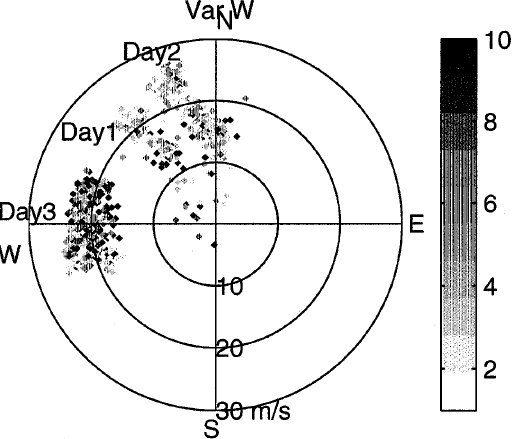
Fig. 7. Variance of vertical wind ( gray scale ) as a function of horizontal wind (polar co-ordinate). Each point represents the variance over one hour during 10 (Day 1), 24 (Day 2) and 26 (Day3) January 1997